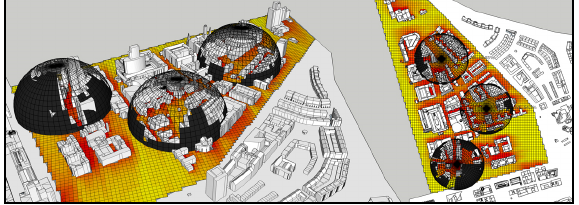
Figure 15. Comparison of SVF for three public spaces in tall buildings area of Rotterdam (cityGML – LOD2), by: author The calculations of SVF indicate, that generally results for user points located between buildings are double less than in other open areas between regular buildings. In case of 3 selected areas results in Rotterdam were 37% (location between tall buildings), 65% and 62% for other squares with regular surrounding buildings. For better understanding this difference and importance of SVF for measuring impact of tall buildings, visualizations from selected viewpoints showing perception of space in place of analysis were generated (Figure 16). The picture at the bottom shows impact on perception at SVF 37% in comparison to locations without tall buildings (upper and middle view – fig. 16).